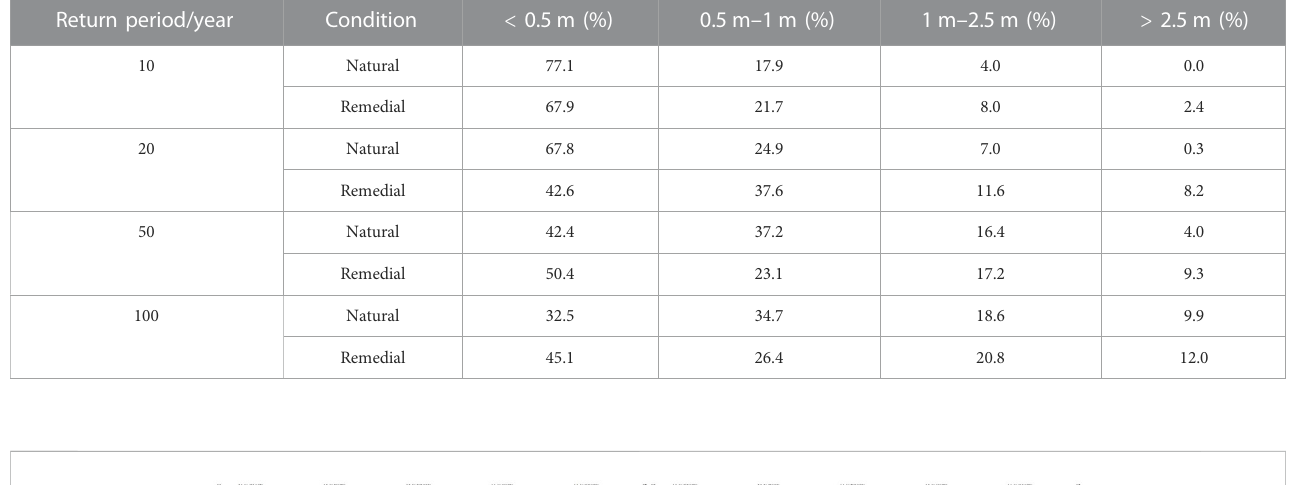
TABLE 3 Percent of fl ow depth before and after retaining dam. Return period/year